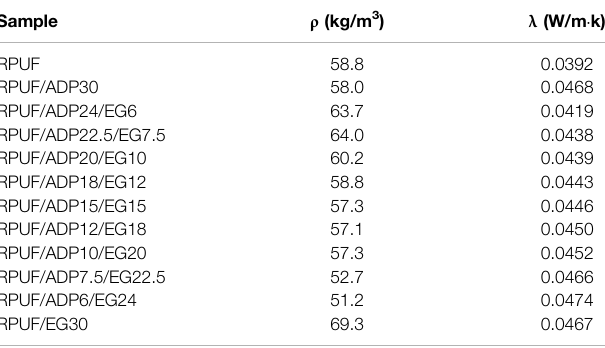
TABLE 2 | Apparent density and thermal conductivity of RPUF and FR-RPUF composites.